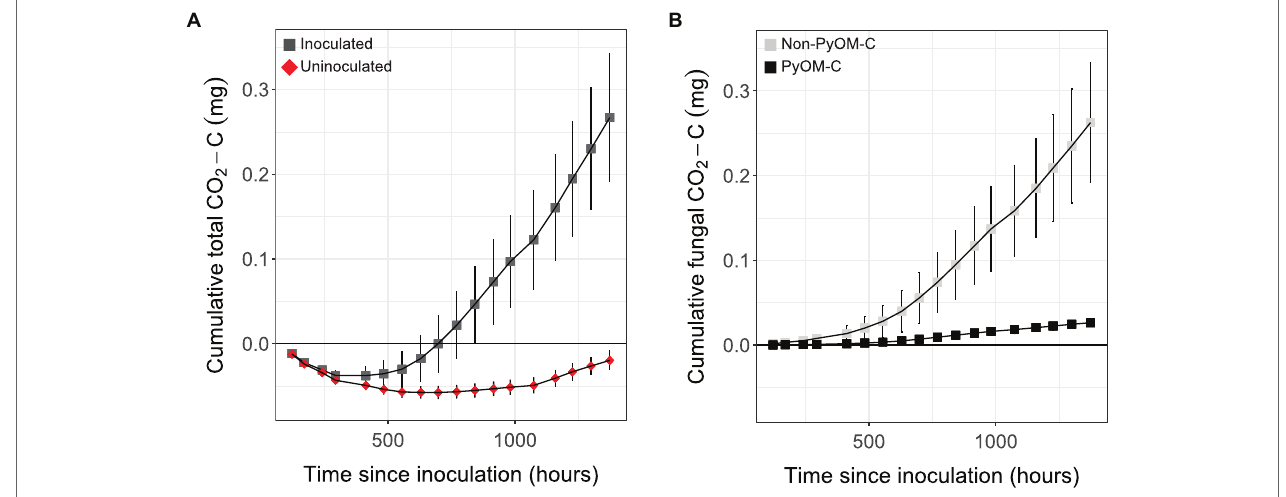
FIGURE 5 | Cumulative mean CO 2 emissions from P. domesticum growing on 13 C-labeled 750 ° C PyOM. (A) Mean cumulative CO 2 measured over time from the enclosed headspace of jars containing either sterile (uninoculated, red diamonds) 750 ° C PyOM agar, or identical plates inoculated with P. domesticum (inoculated, dark grey squares; n = 5, error bars = SE). (B) Mean cumulative CO 2 from P. domesticum inoculated jars, normalized by the uninoculated controls, and then partitioned into PyOM-derived C (black squares) and non-PyOM-derived C (light grey squares) using 13 C partitioning ( n = 5, error bars =